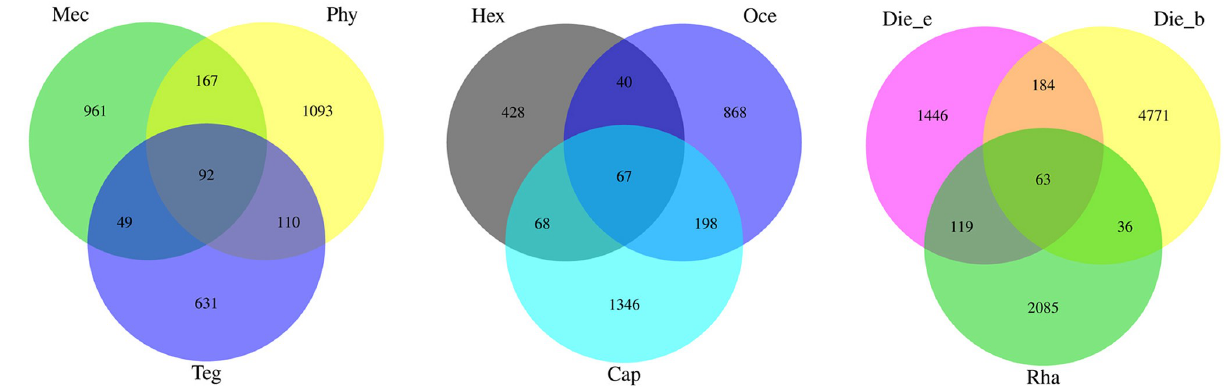
Fig 1. Venn diagram of the gut bacterial communities features in different feeding habits. Shared features were shown in core.